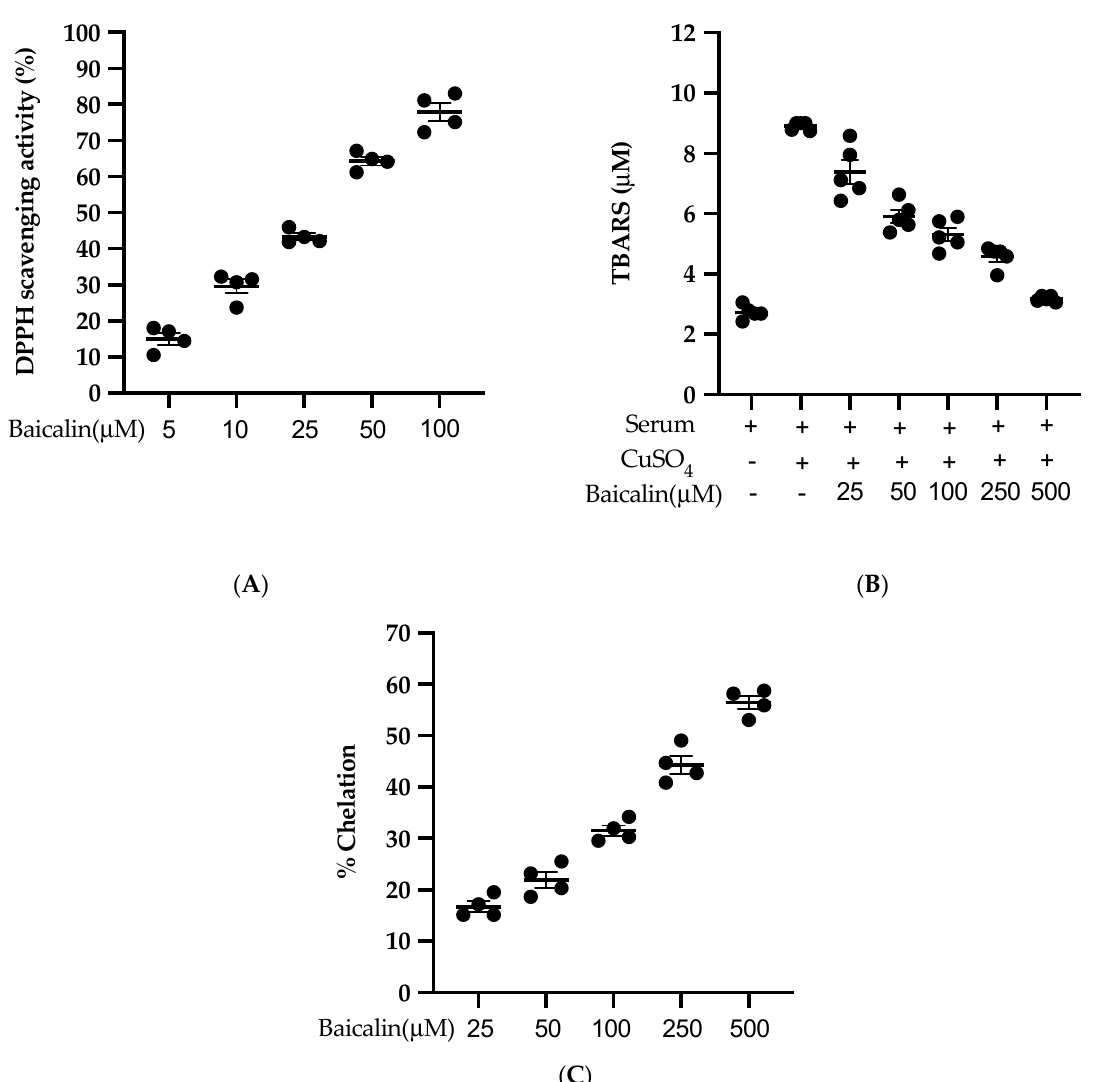
Figure 8. Antioxidant activity of baicalin ( A ) % of DPPH radical scavenging activity was calculated using five different doses of baicalin. An equal volume of baicalin and methanolic solution of DPPH was incubated for 30 min in the dark, and absorbance was taken at 517nm. ( B ) Measurement of thiobarbituric acid reactive substance (TBARS) level was performed by comparison with the standard curve obtained using various dilutions of malondialdehyde (MDA). ( C ) A various dose of baicalin was incubated with FeSO 4 and 2,2 ′ bipyridyl. The absorbance of the resulting chromophore was read at 540nm. Each value is the mean ± SE of four-five independent experiments.